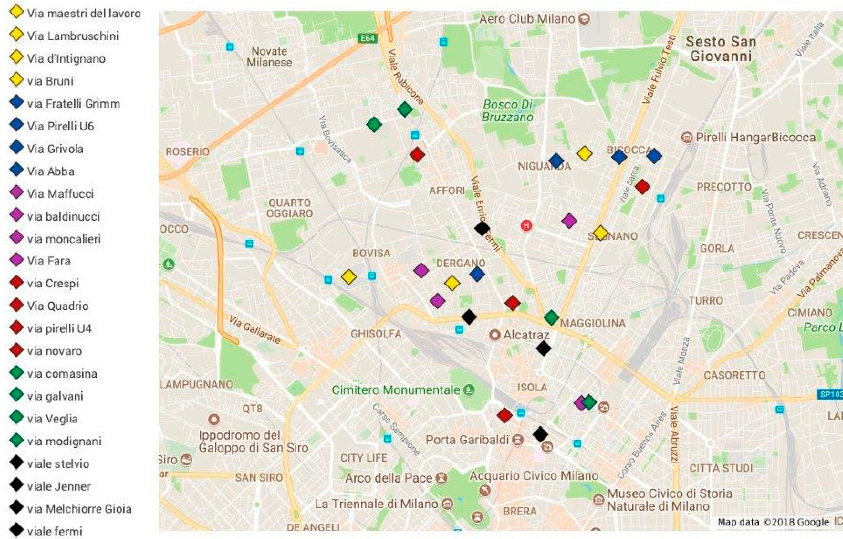
Figure 10. Locations of 24 monitoring noise stations on Z9. The inset on the left side of the figure reports the names of the streets of each monitoring station. The same color refers to stations belonging to the same group g .